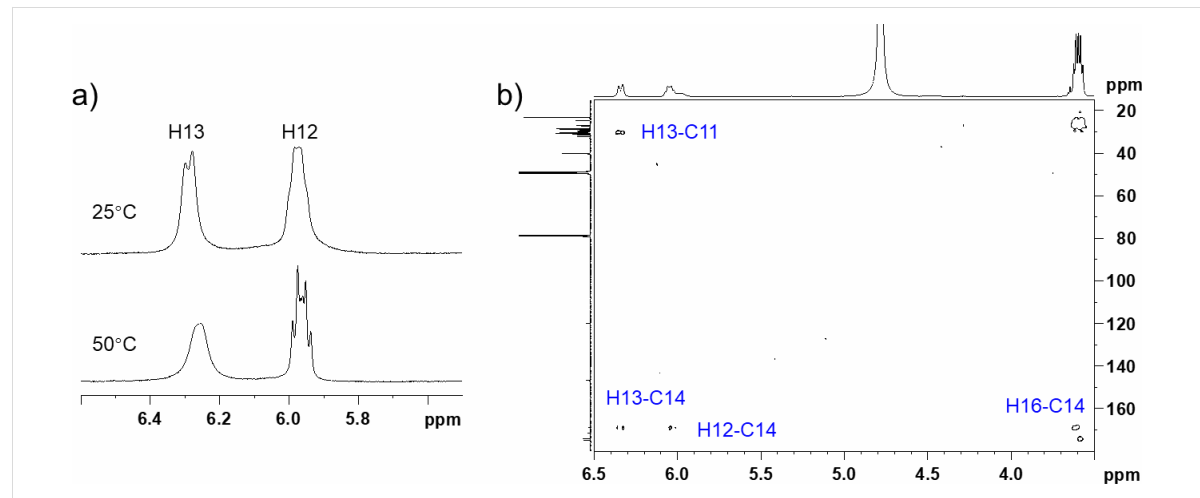
Figure 3: (a) Partial 1 H NMR spectra of 1 at 25 and 50 °C in DMSO- d 6 ; (b) magnified HMBC spectrum of 1 at 25 °C in CDCl 3 /CD 3 OD